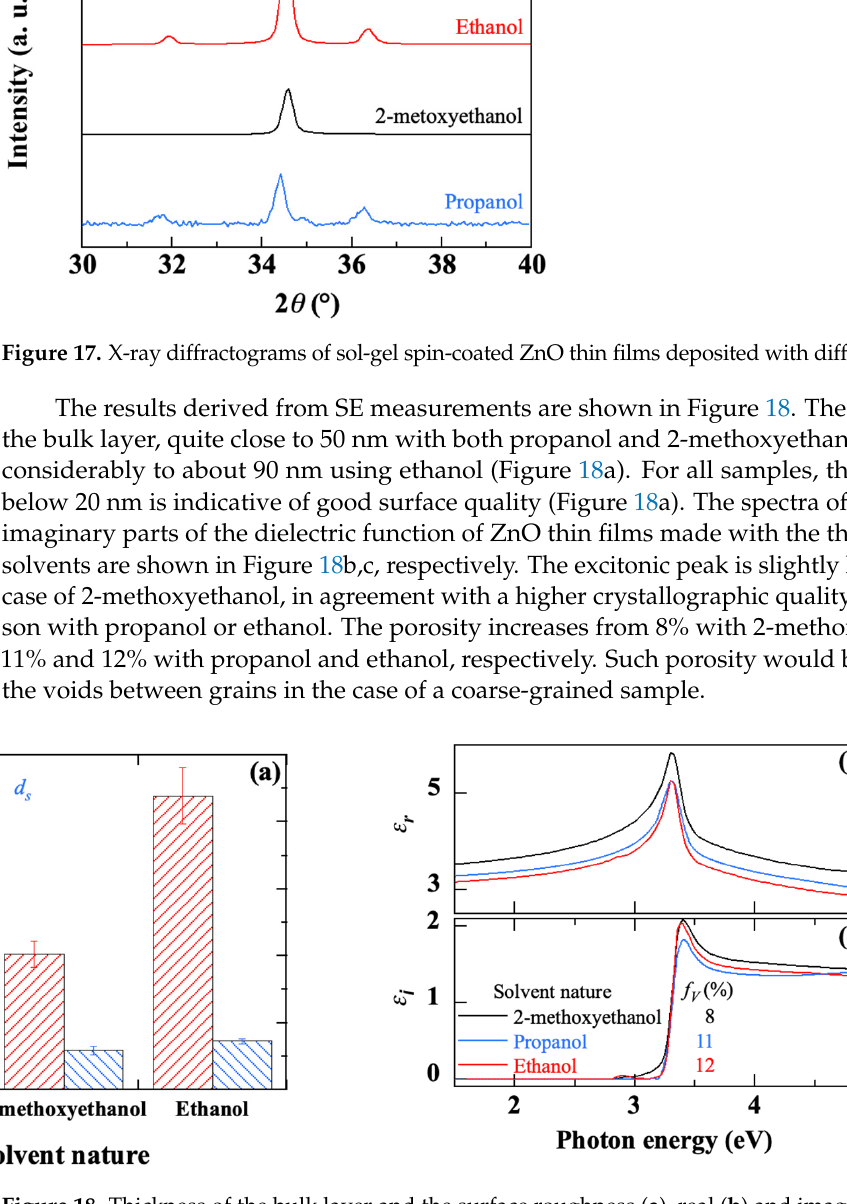
Figure 16. AFM micrographs of sol-gel spin-coated ZnO thin films deposited with propanol ( a ) and ethanol ( b ) and AFM results of ZnO thin films deposited with different solvents ( c ).